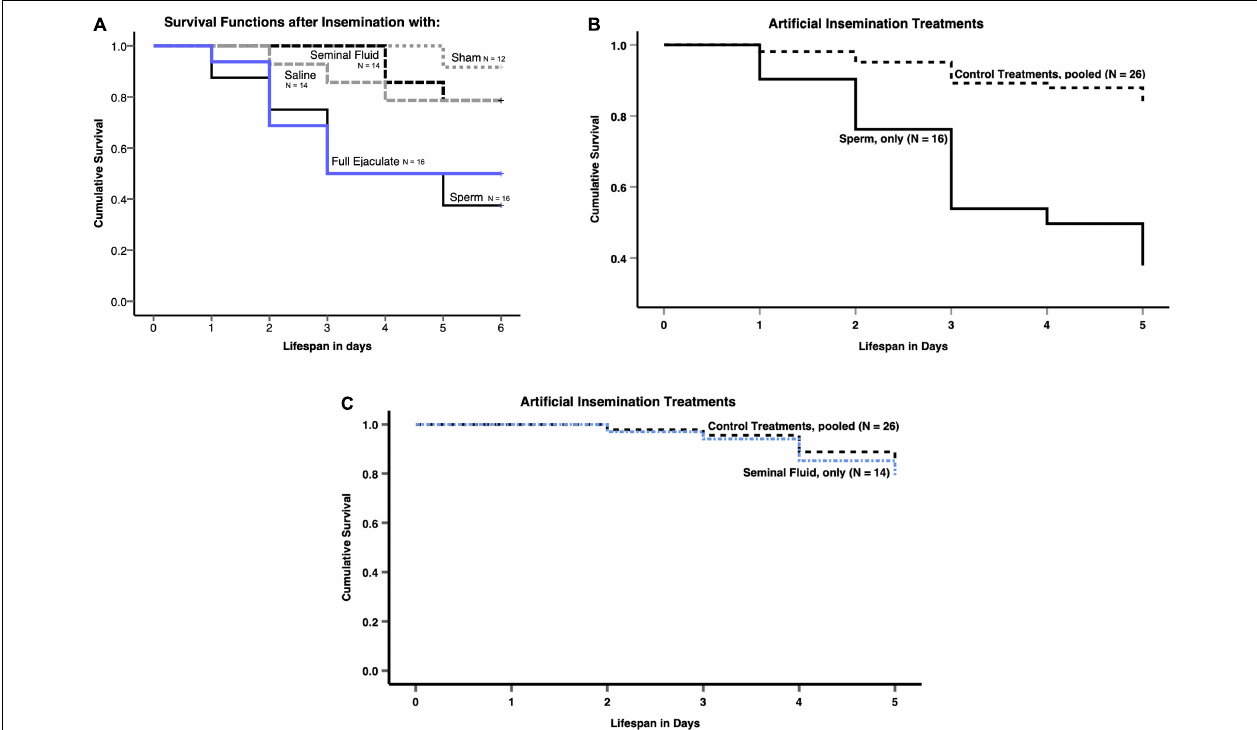
FIGURE 1 | (A) Kaplan-Meier survival functions of Atta colombica queens after artificial insemination with either: full ejaculates, sperm only, seminal fluid only, a Hayes saline solution, or a sham treatment. (B) Comparison of Kaplan-Meier survival functions of Atta colombica queens after pooling treatments, so they could be subdivided in inseminations involving sperm and “inseminations” not involving sperm. (C) Comparison of Kaplan-Meier survival functions of Atta colombica queens after pooling treatments, so they could be subdivided in “inseminations” involving seminal fluid and inseminations not involving seminal fluid.